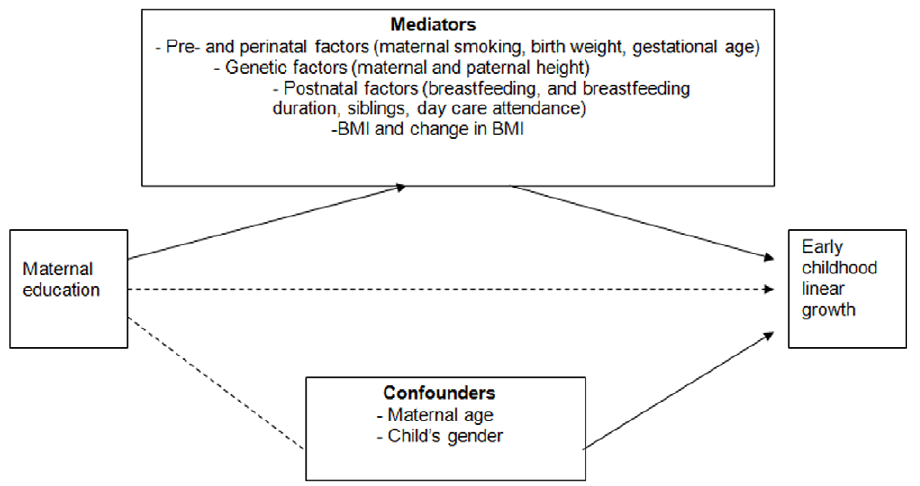
Figure 1. Theoretical model of pathways by which maternal education might influence early childhood linear growth.